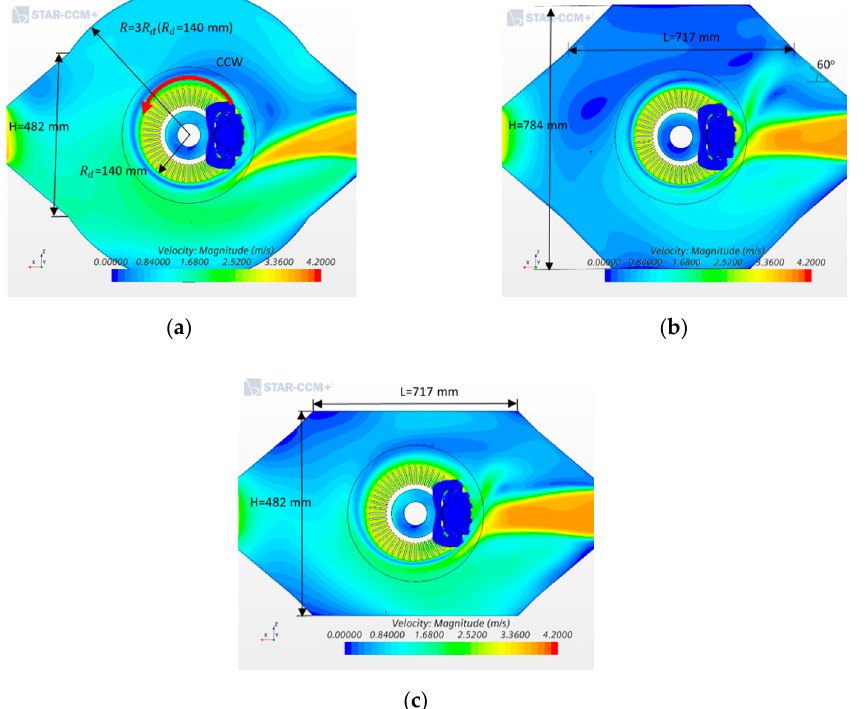
Figure 4. Flow velocity magnitude: ( a ) circular design; ( b ) hexagonal design; ( c ) rectangular design.